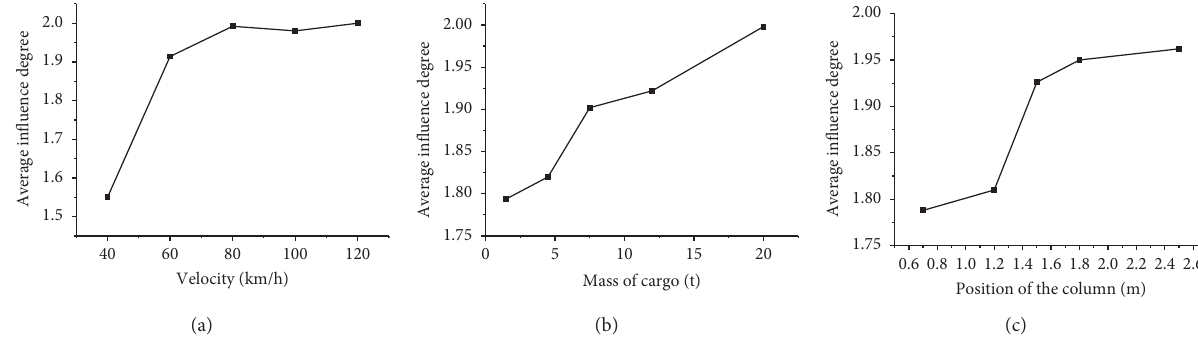
Figure 12: Single-factor analysis. (a) Velocity influence. (b) Massin fluence. (c) Position